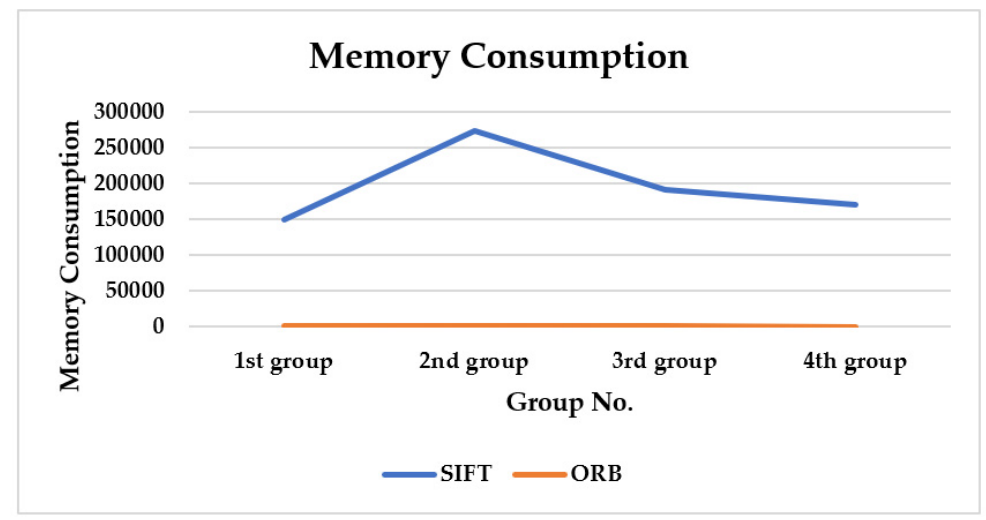
Figure 11. Average consumed memory for extracted features over the four groups created from ImageNet-Sketch dataset using handcrafted features.